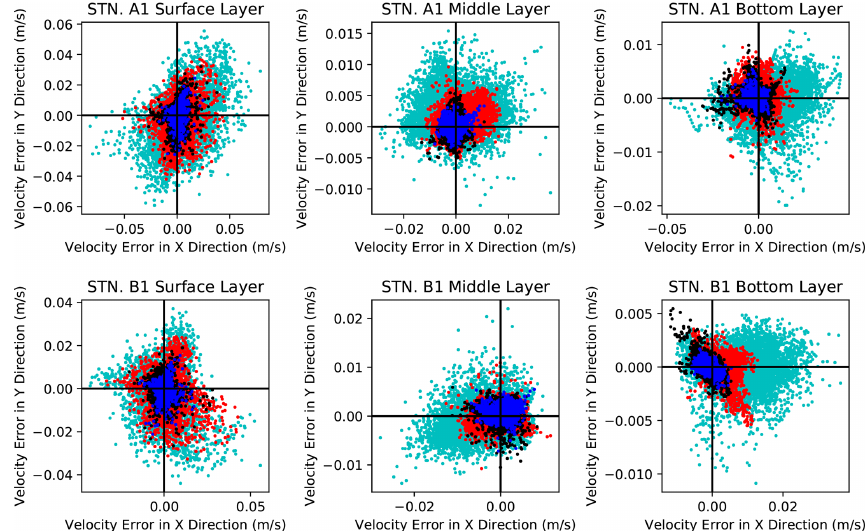
( X ∗ ) and observed t,j